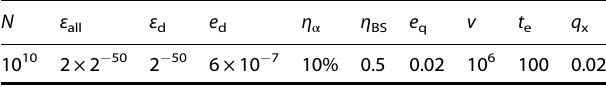
Table 1. List of the experiment parameters used in numerical